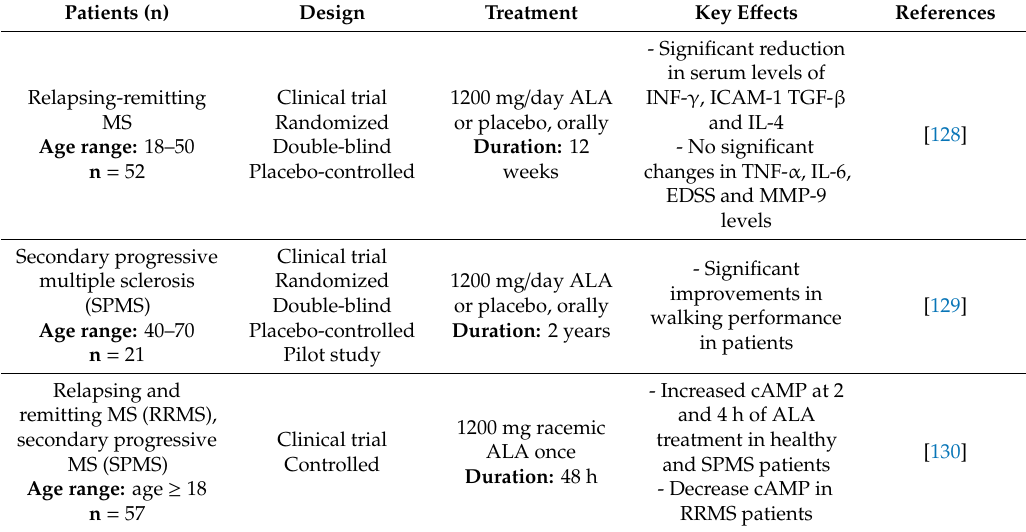
Table 4. E ff ects of ALA in patients with multiple sclerosis